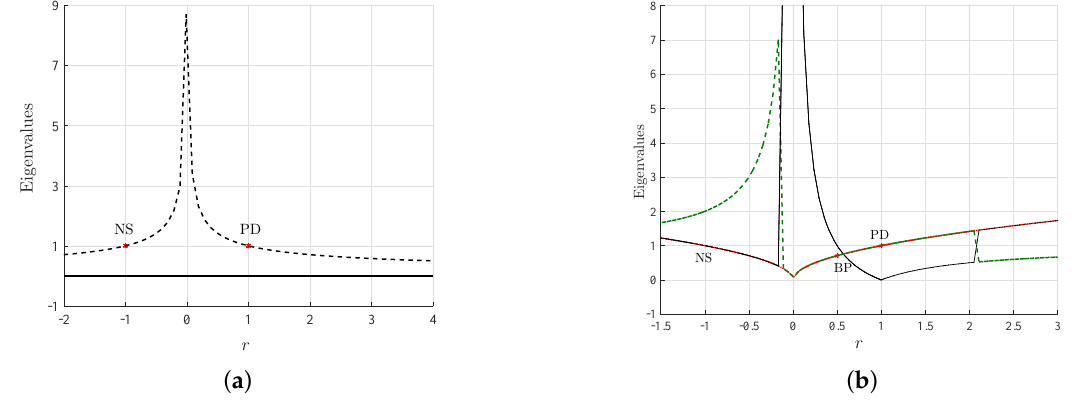
Figure 2. The eigenvalues values during fixed point continuation using the three fixed points of Equation (7): ( a ) the eigenvalues corresponding to X 1 ; and ( b ) the eigenvalues corresponding to X 2 (dashed) and to X 3